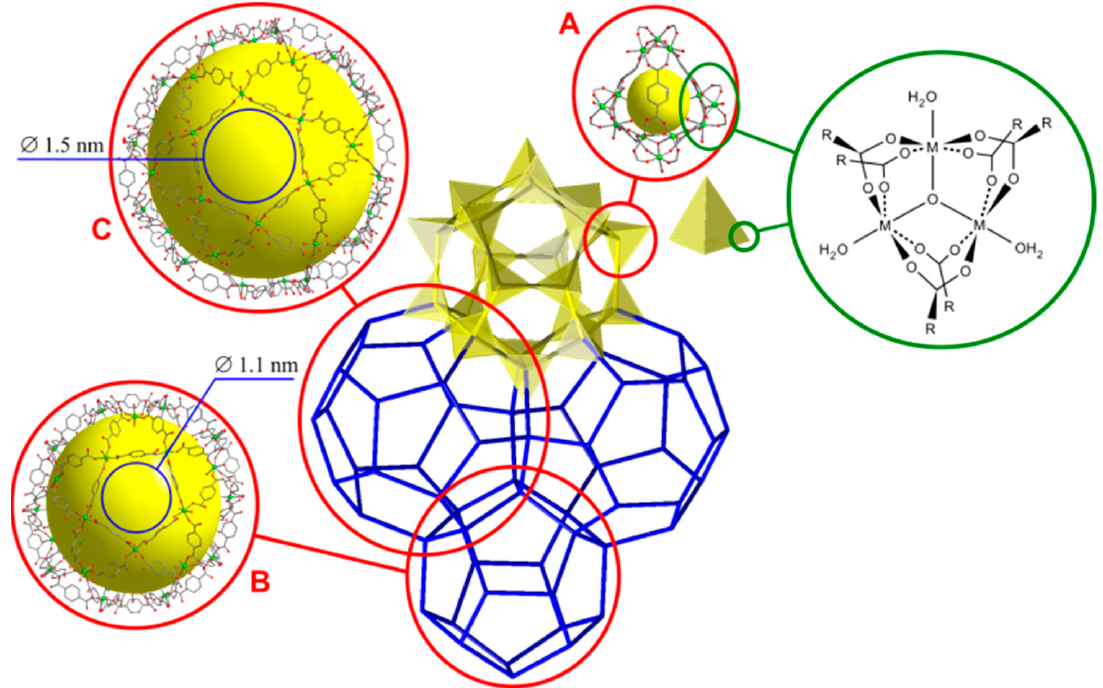
Figure 1. The representation of the MIL-101(Cr) zeolite-like structure formed by three-nuclear clusters [Cr 3 O(H 2 O) 3 (O 2 CR) 6 ] + and terephthalate linkers, which has three types of cages: microporous cages A with inner diameter of 8 Å and windows size of ca. 4 Å; small mesocages B with inner diameter of 29–30 Å and windows size of ca. 11 Å and large mesocages C with inner diameter of 34–38 Å and windows size of ca. 15 Å.